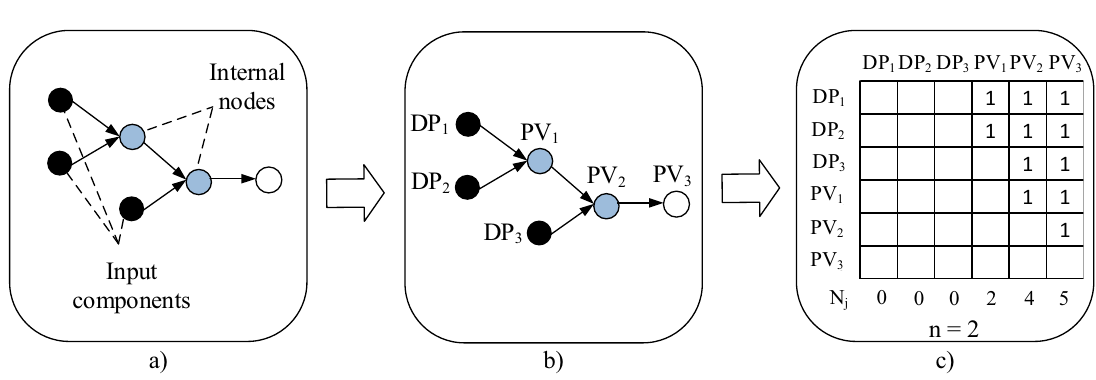
Figure 3. ( a ) ALS model; ( b ) ALS model described using AD notation; ( c ) related visibility